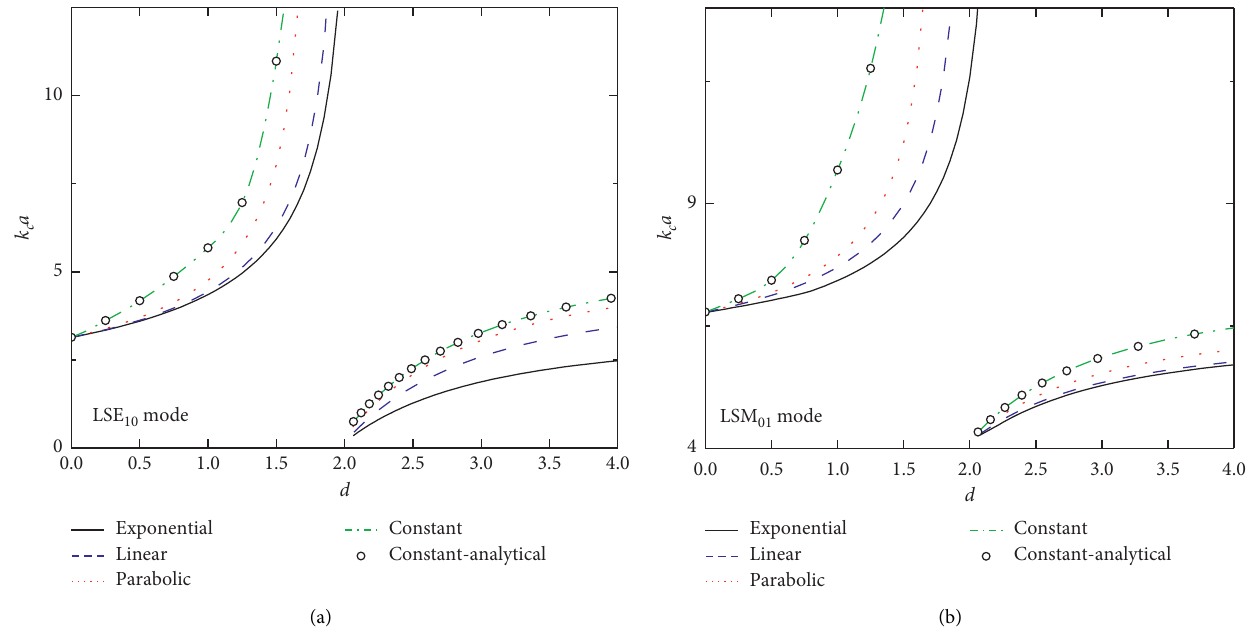
Figure 3: The normalized cutoff wavenumbers k (a) LSE 10 mode and (b) LSM 01